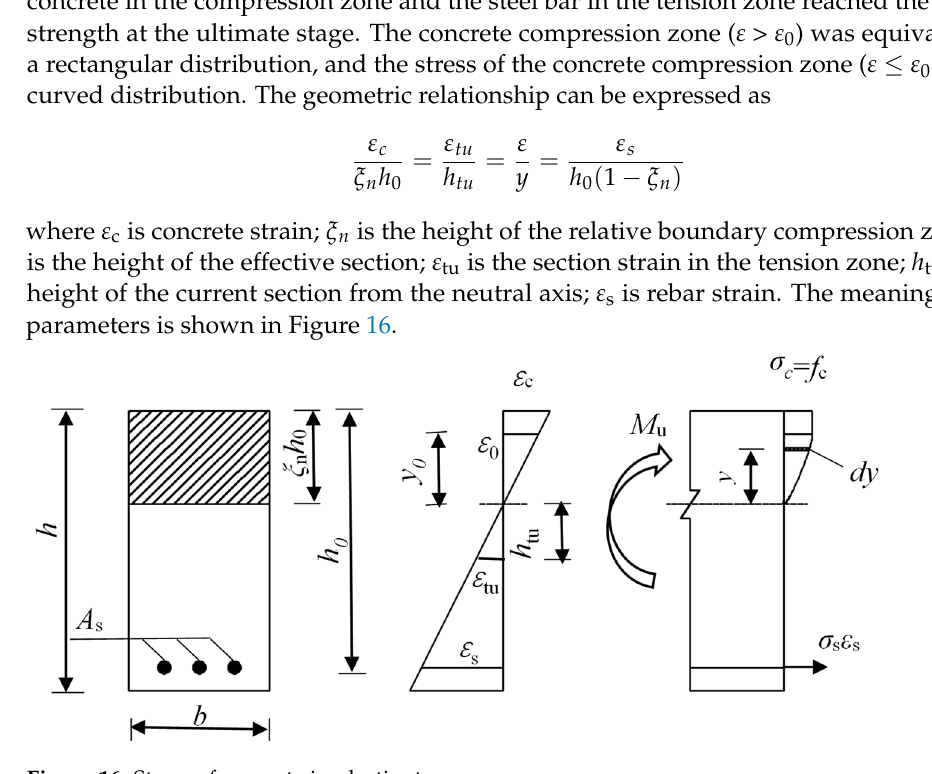
Figure 16. Stress of concrete in plastic stage.